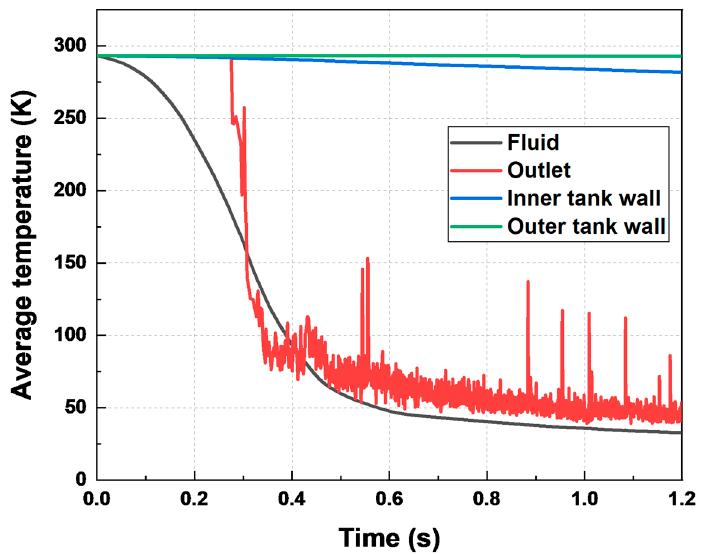
Figure 12. Variation in the average temperatures according to charging process.